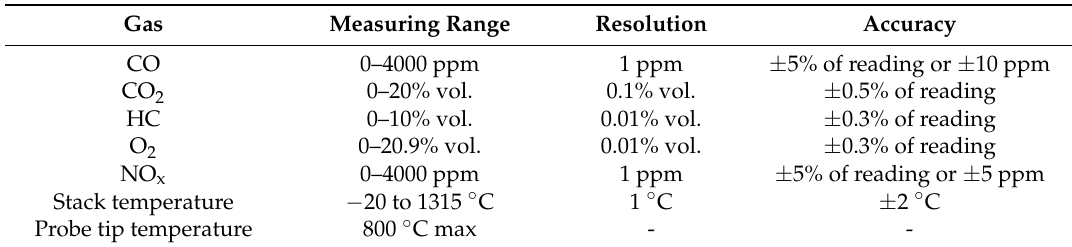
Table 2. Specifications of the exhaust gas